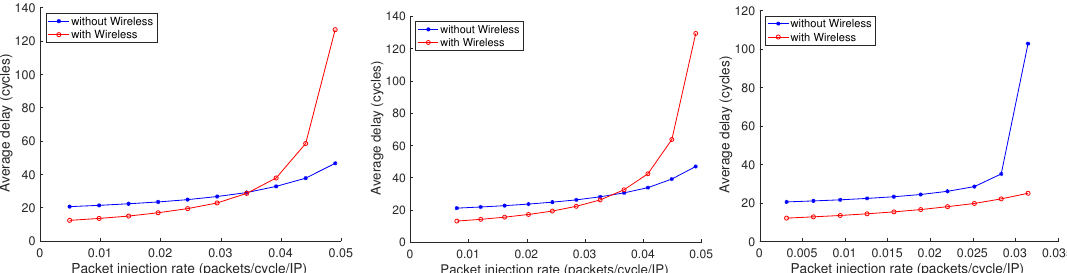
Figure 11. Average delay for profiles T 4 , T 8 , and T 16 for 256 Delta MIN topology and table-based traffic (TT-256 Delta MIN).